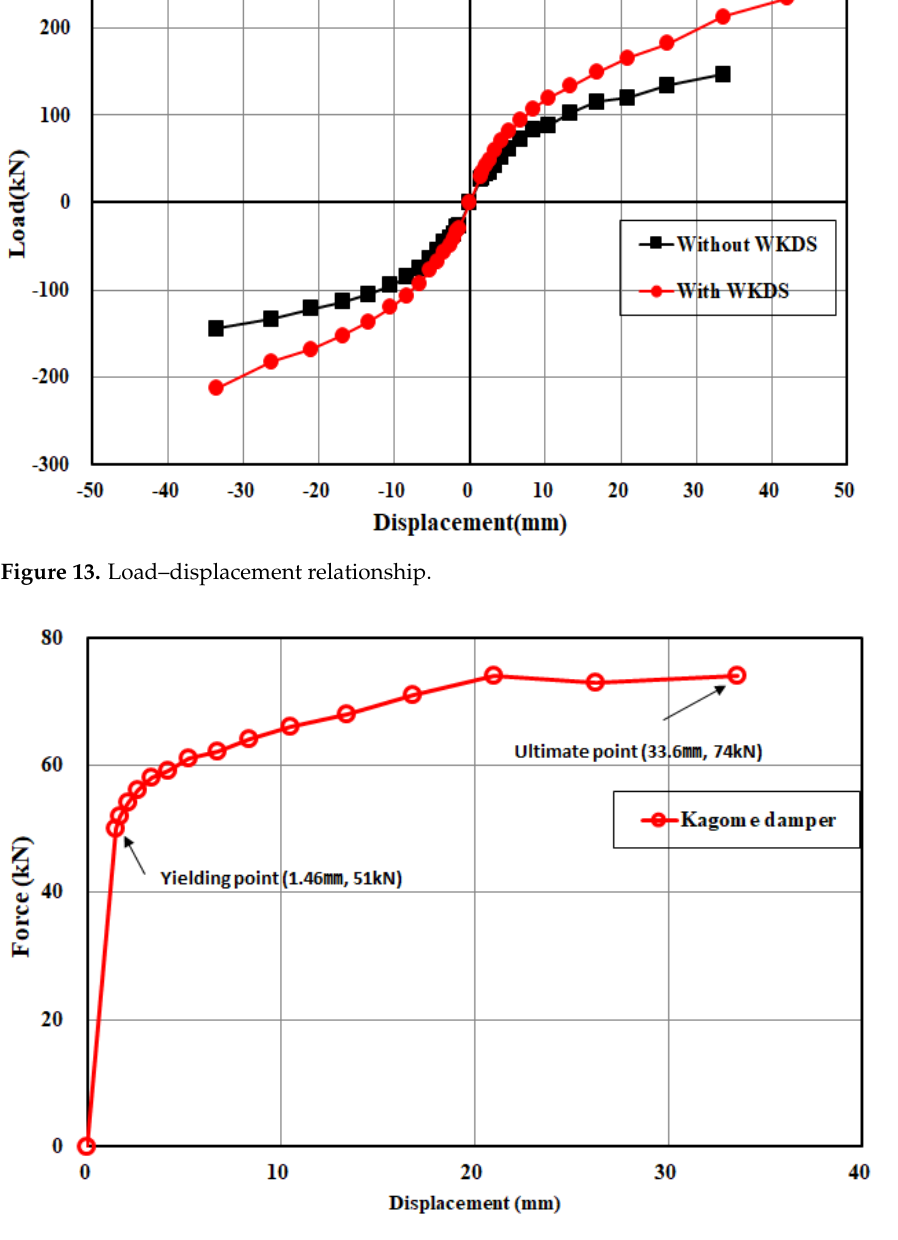
Figure 14. Load–displacement relationship of Kagome Figure 14. Load – displacement relationship of Kagome damper.